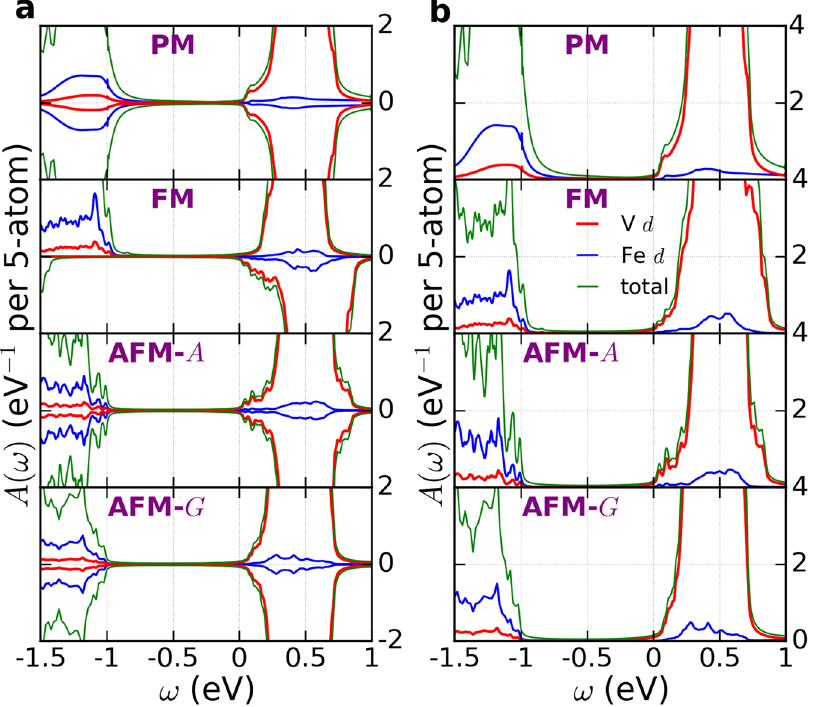
Figure 4. Spectral functions A ( ω ) of tetragonal double perovskite Ba 2 VFeO 6 for different magnetic states. The unit of A ( ω ) is eV − 1 per 5-atom. ‘PM’ stands for paramagnetic state, ‘FM’ for ferromagnetic state, ‘[001]-AFM’ for [001] antiferromagnetic state and ‘[100]-AFM’ for [100] antiferromagnetic state. Panels a) spin-resolved spectral function. The positive (negative) y -axis corresponds to spin-up (spin-down). Panels b) total spectral functions (summing over spin-up and spin-down). The red, blue and green curves are for Fe d , V d and O p , respectively. The Fermi level is set at ω = 0 eV.